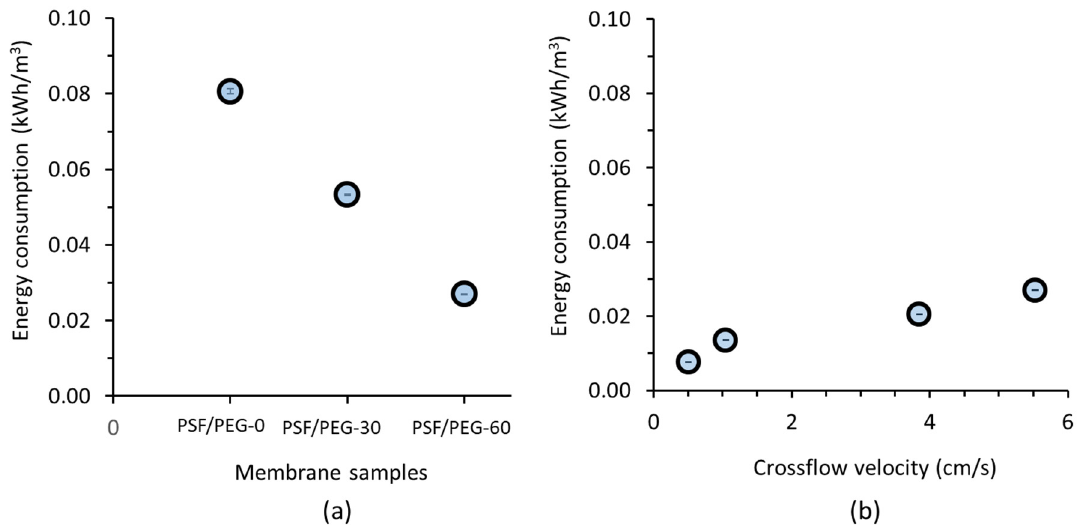
Figure 6. Specific energy consumption for filtration of 1000 ppm oil/water emulsion as a function of ( a ) applied membrane material and ( b ) energy consumption using PSF/PEG-60 membrane as a function of applied crossflow velocity using the permeability data at the final reading of the fifth filtration cycle.